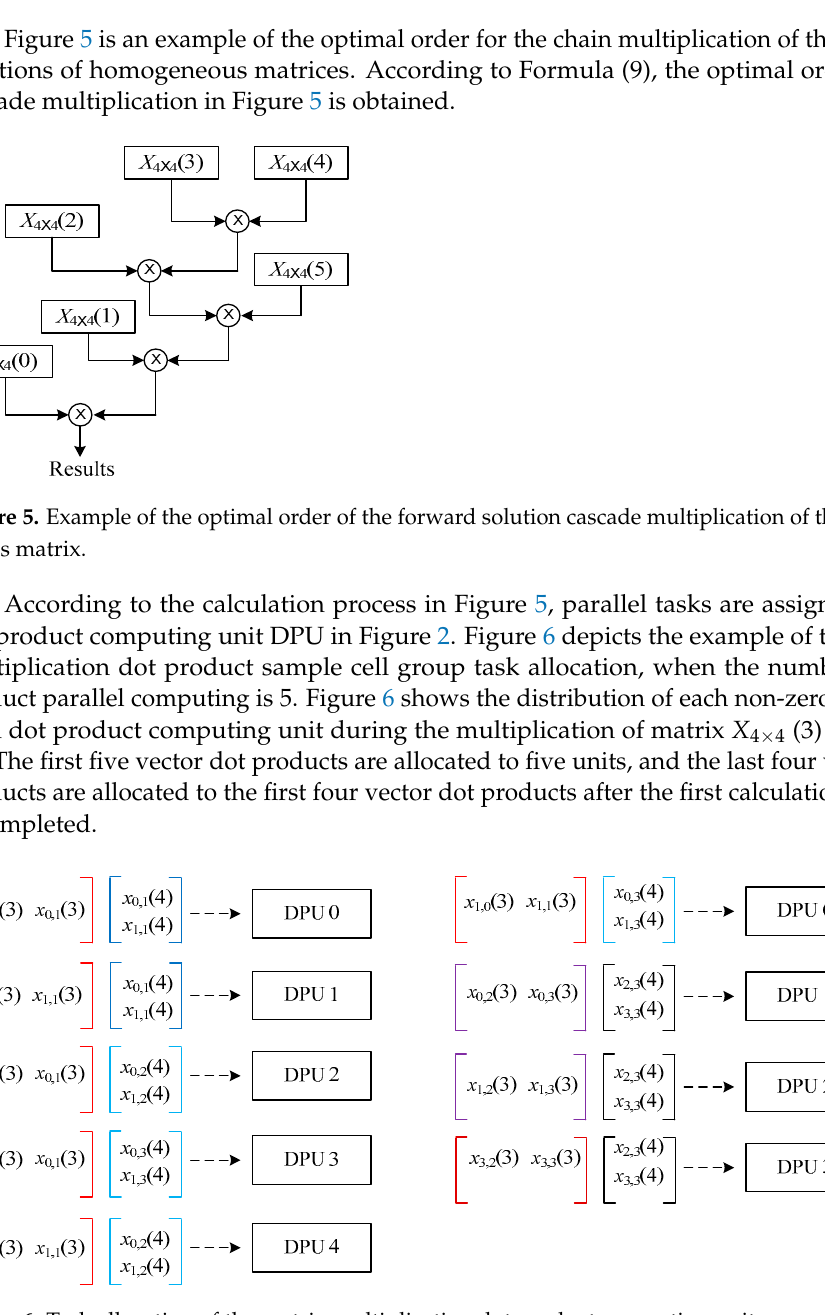
Figure 6. Task allocation of the matrix multiplication dot product computing unit group.